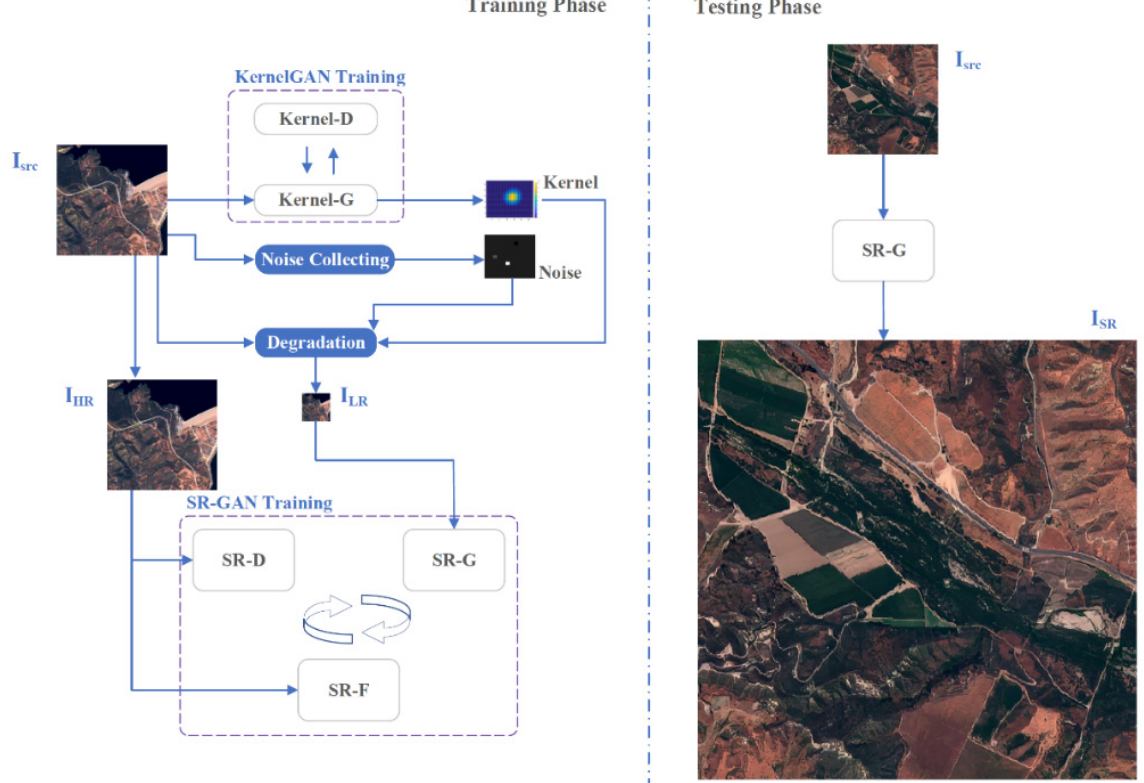
Figure 2. Structure of TS-SRGAN on Sentinel-2 remote-sensing images.